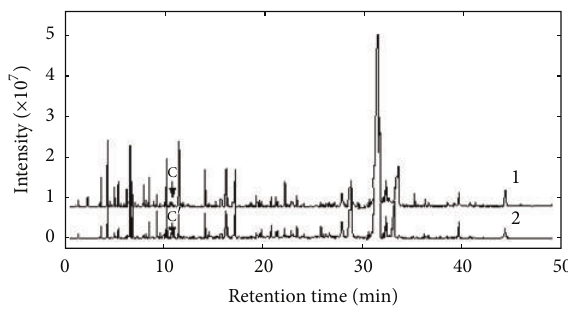
Figure 7: The chromatograms of the volatile components in the main root (curve 1) and leaf (curve 2) of Agrimonia eupatoria